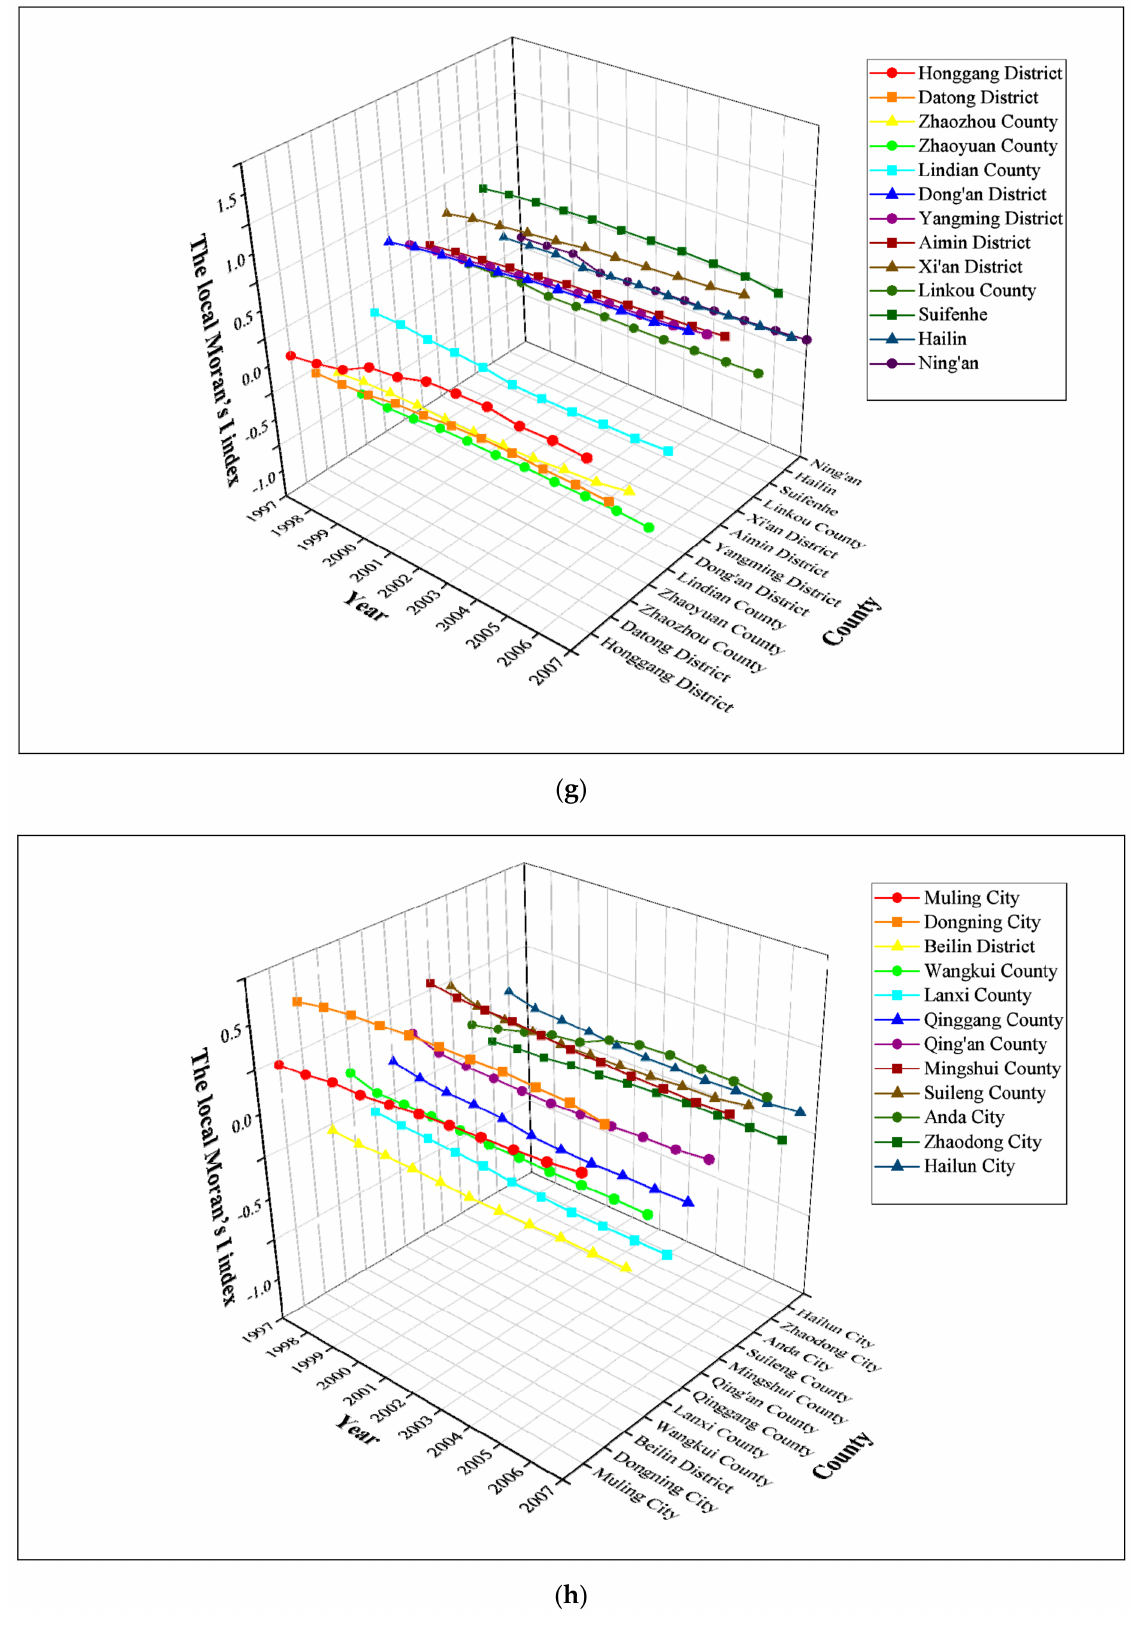
Figure 3. The local Moran’s I index of the Harbin–Changchun urban agglomeration from 1997 to 2007 (Panel ( a – h ) include the 103